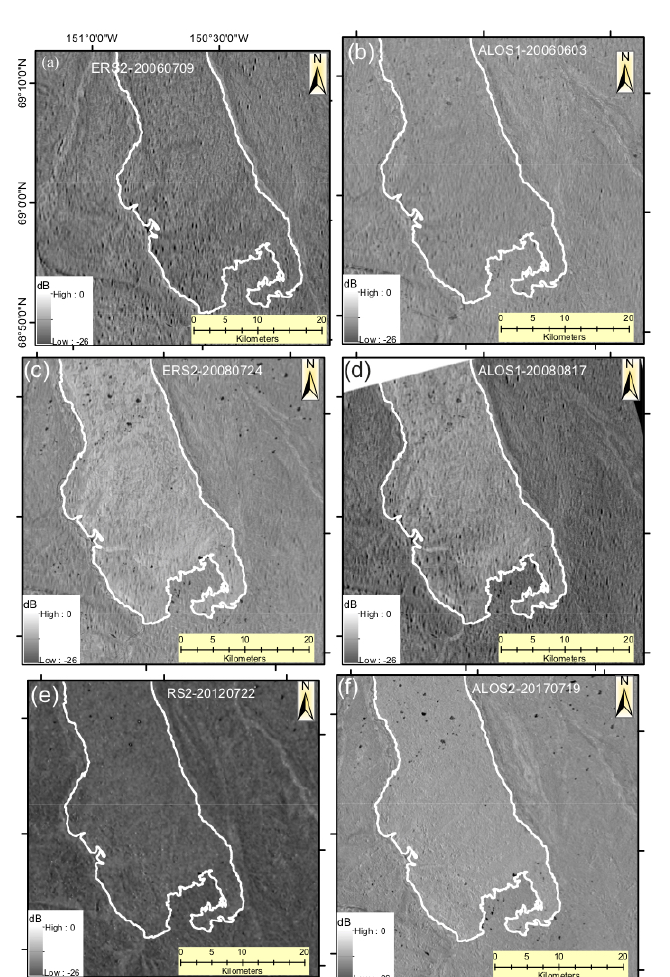
Figure 2. Images of backscatter coefficient that span before and after the fire. The white polygon marks the fire boundary. ( a ) and ( b ) present the images acquired from ERS2 and ALOS-1 before the fire. ( c ), ( d ), ( e ), and ( f ) present the post-fire images acquired from ERS2, ALOS-1, RS-2, and ALOS-2, respectively.